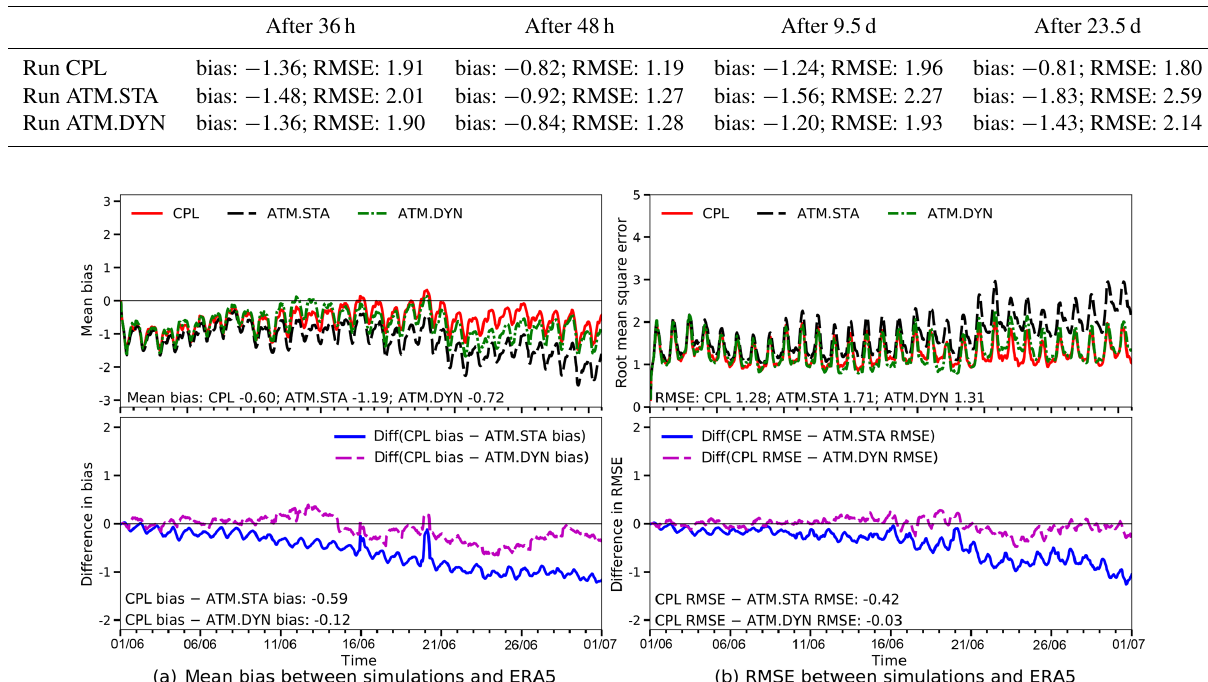
Figure 6. The bias and RMSE between the T 2 obtained by the simulations (i.e., ATM.STA, ATM.CPL, and CPL) in comparison with ERA5 data. Only the errors over the Red Sea are considered. The differences between the simulation errors from CPL and stand-alone WRF simulations are presented below the mean bias and the RMSE. The initial time is 00:00UTC 1 June 2012 for all simulations.